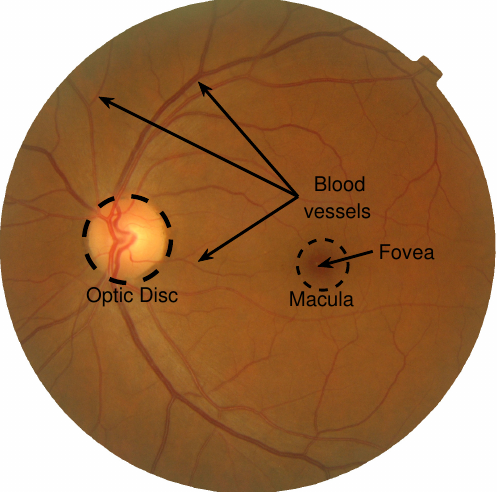
Figure 1. Internal characteristic elements of a fundus image: macula, fovea, optic disk, and blood